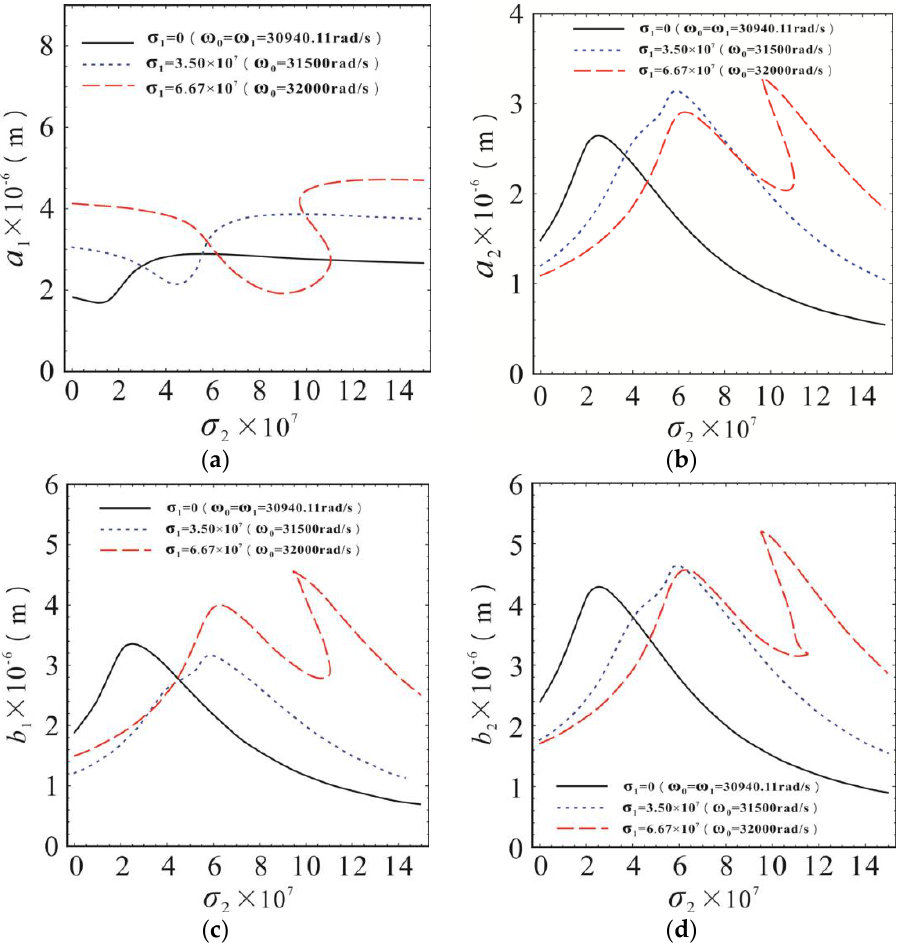
Figure 7. The variation curves of the response amplitude of each degree of freedom of the system with σ 2 at different operating frequency ω 1 . ( a ) Relationship between response amplitude of the first-order drive mode and σ 2 ; ( b ) Relationship between response amplitude of the second-order drive mode and σ 2 ; ( c ) Relationship between response amplitude of the first-order sense mode and σ 2 ; ( d ) Relationship between response amplitude of the second-order sense mode and σ 2 . The solid lines represent the stable solution. The dashed lines represent the unstable